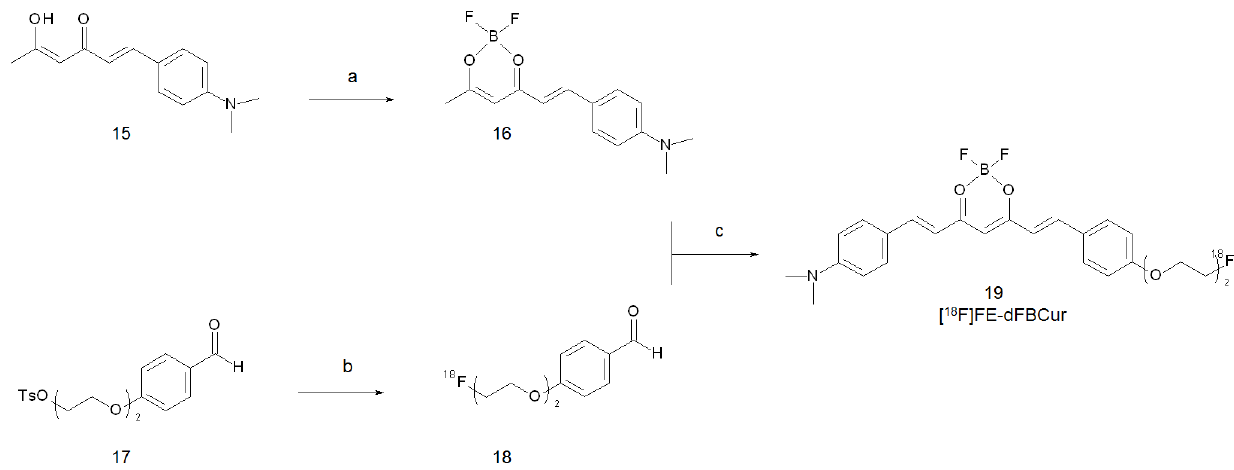
Figure 5. Reagents and conditions: ( a ) BF 3 ·Et 2 N, CH 2 Cl 2 , RT, 3 h; ( b ) n-Bu 4 N[ 18 F]F, CH 3 CN, 110 °C, 10 min; ( c ) n-butylamine, ethyl acetate, 110 °C, 20 min.